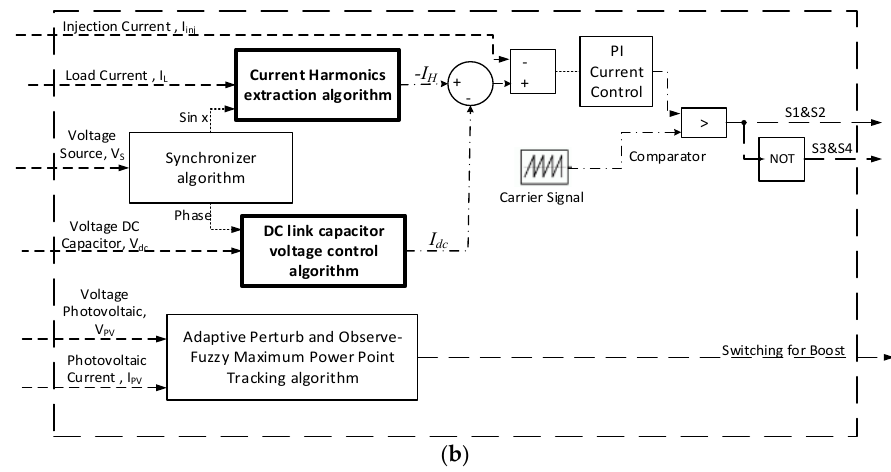
Figure 2. Single-phase PV SAPF: ( a ) circuit diagram and ( b ) control strategies.